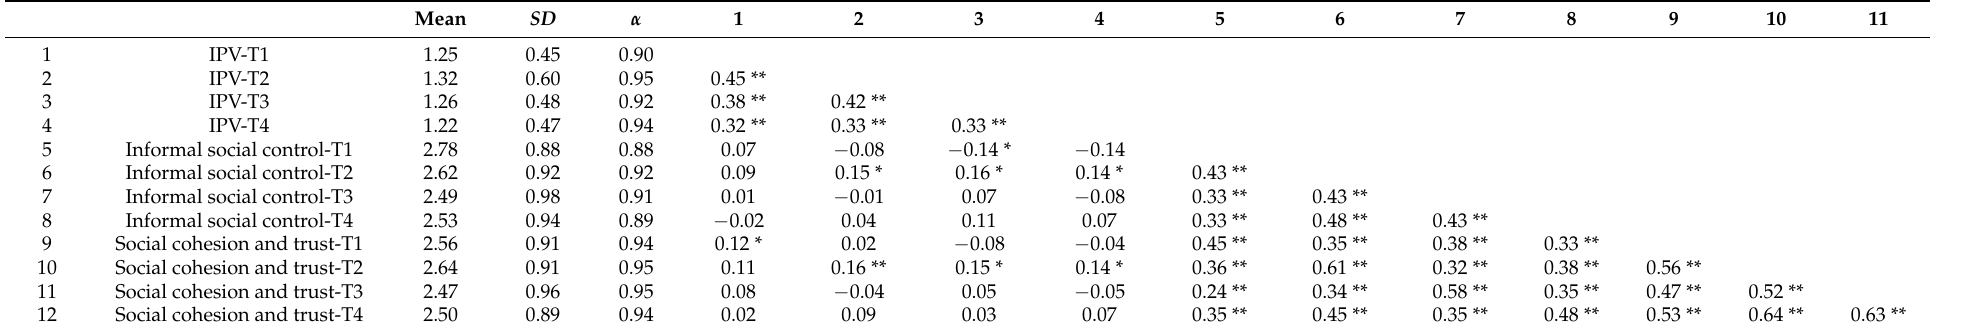
Table 1. Means, standard deviations, reliability coefficients, and inter-correlations of variables for each time point.